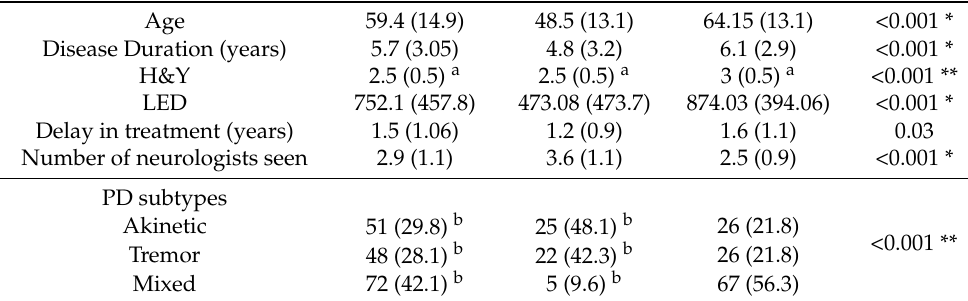
Table 1. Demographic and clinical variables by origin of the patients.